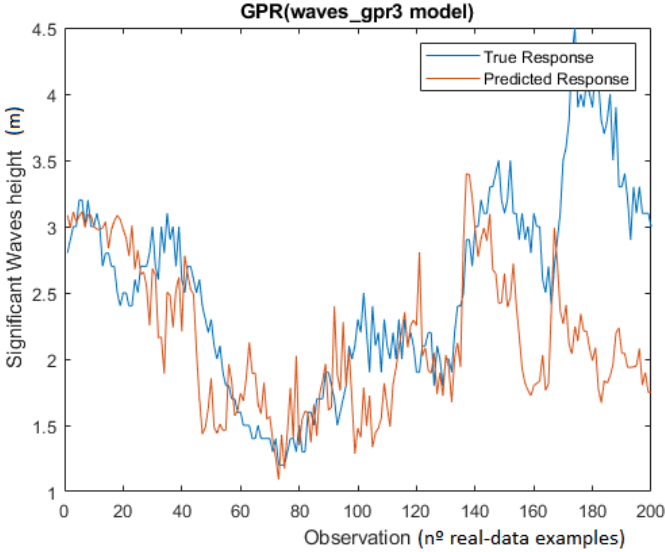
Figure 8. Predicted vs. real output for waves_gpr3 model for the first 200 data of